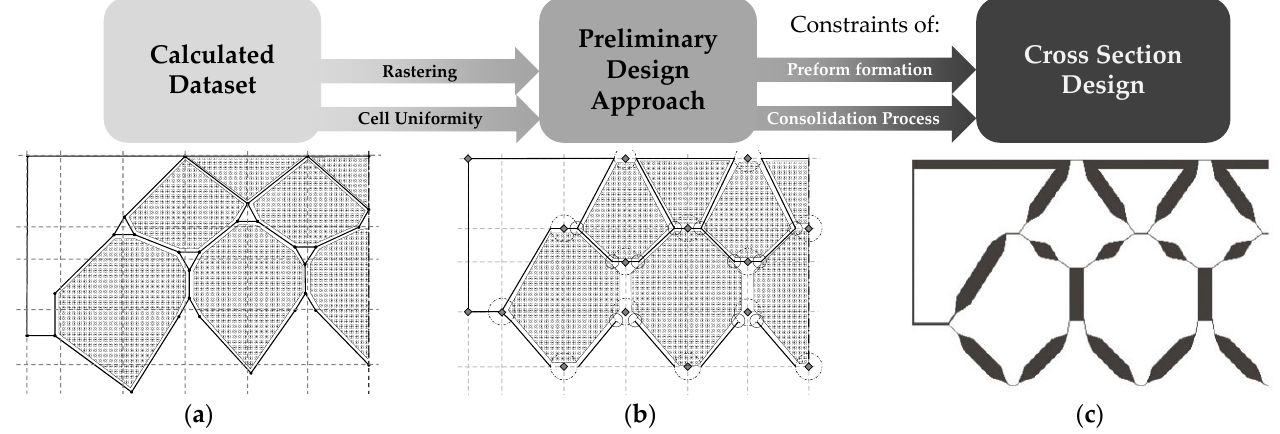
Figure 5. Steps of the geometry derivation for double row PACS (half ‐ cross ‐ sectional images of the symmetrical structure displayed): ( a ) calculated raw dataset and rastering; ( b ) processed dataset with aligned cell geometry; ( c ) derived cross section.